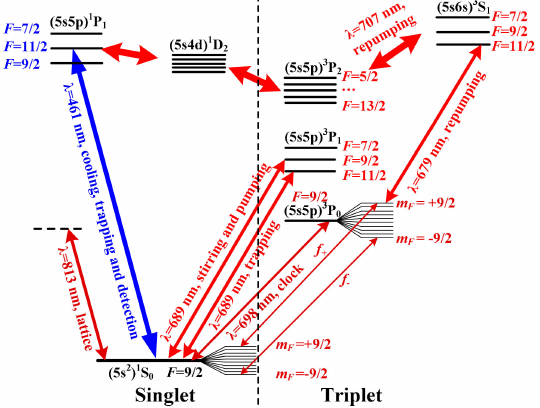
Figure 1. Energy level scheme of the 87 Sr